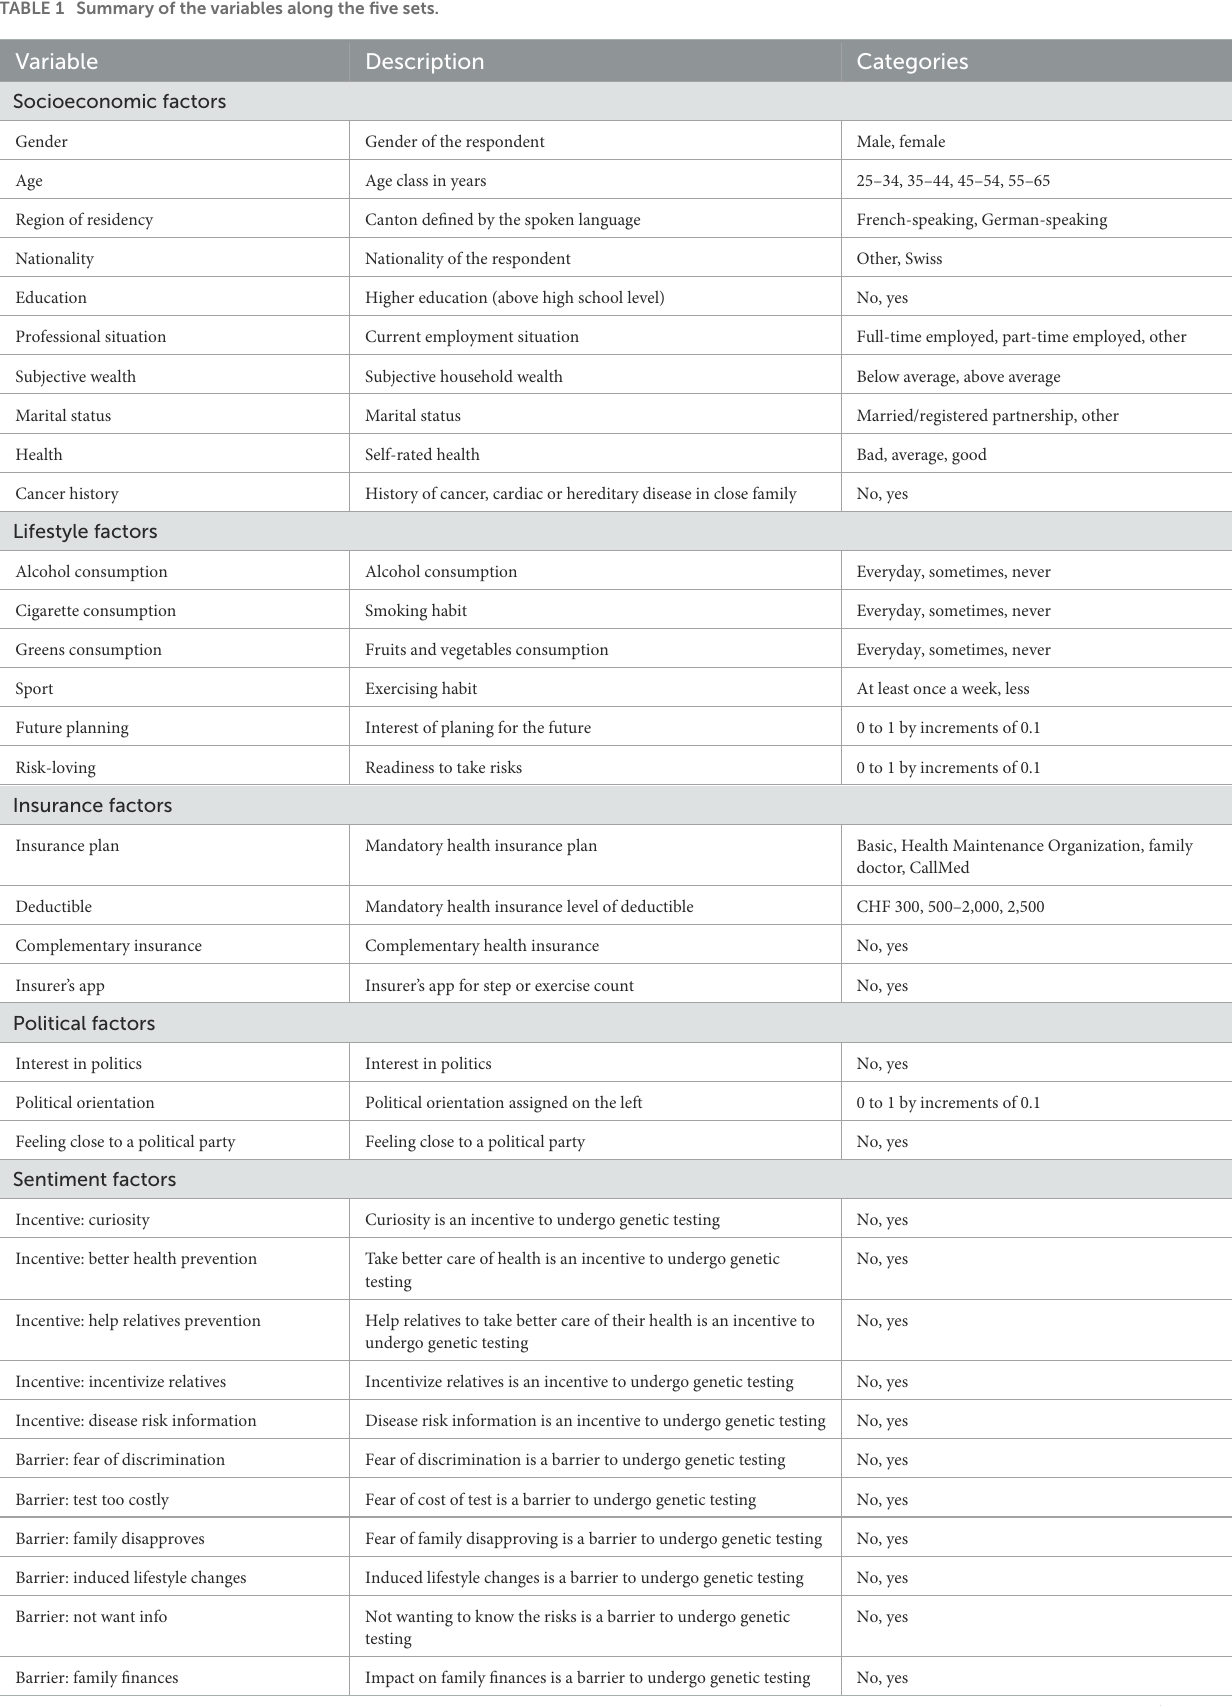
TABLE 1 Summary of the variables along the five sets.